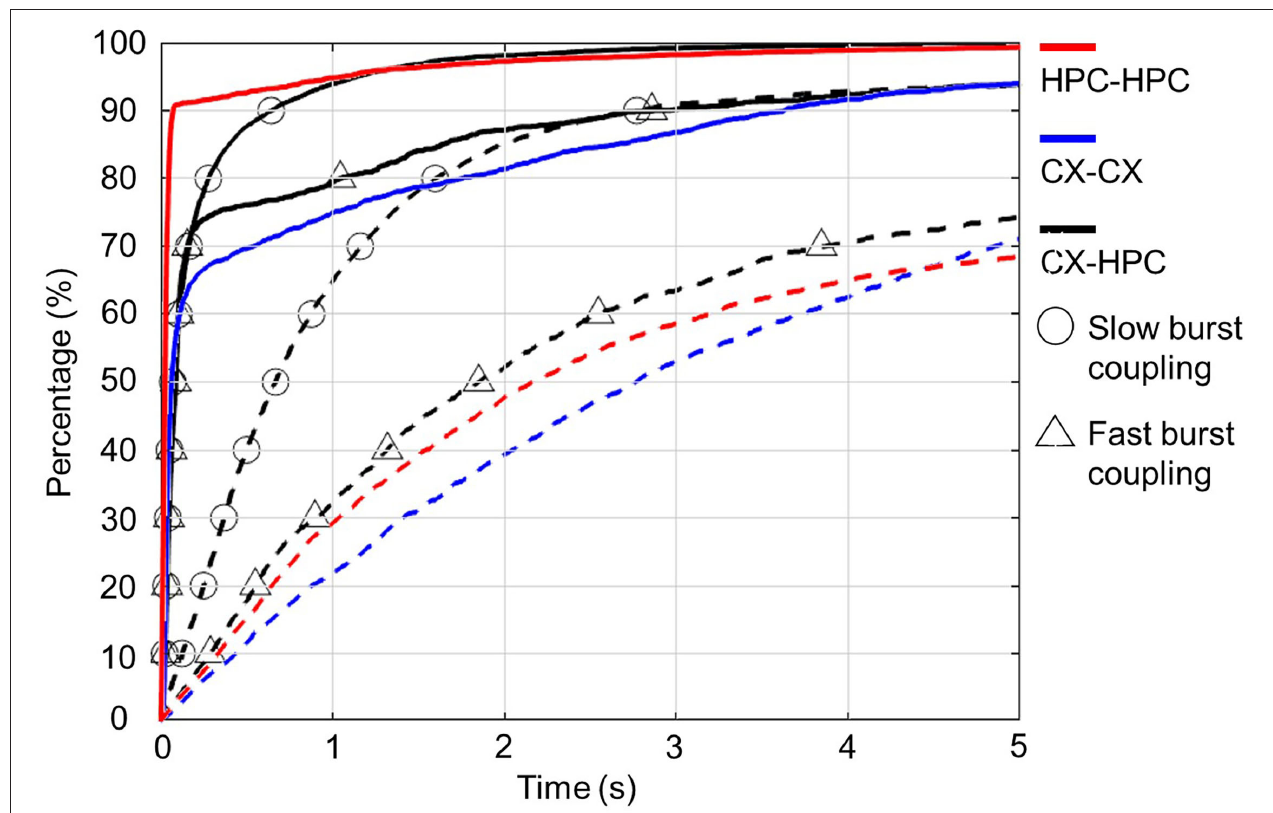
FIGURE 3 | Synchronization of inter-network bursts in homogeneous and heterogeneous cocultures. Each plot shows the cumulative distribution of the absolute value of the inter-network deviation of the start times in pairs of bursts. The cumulative distribution functions (CDF) of the original start-time deviations are plotted as solid lines, and the CDFs of the shuffled start-time deviations are plotted as dashed lines. Homogeneous and heterogeneous cocultures are distinguished by color: homogenous neocortical (CX-CX) cocultures are shown in blue, and homogenous hippocampal (HPC-HPC) cocultures are shown in red, and heterogenous neocortical-hippocampal (CX-HPC) cocultures are shown in black. The CDFs of CX-HPC cocultures are further separated into two groups showing burst coupling and fast burst coupling, marked by circles and triangles, respectively. All unshuffled plots show that over 70% of the inter-network burst pairs had start-time deviations shorter than 500ms. In contrast, the inter-network burst events show longer deviations after start-time